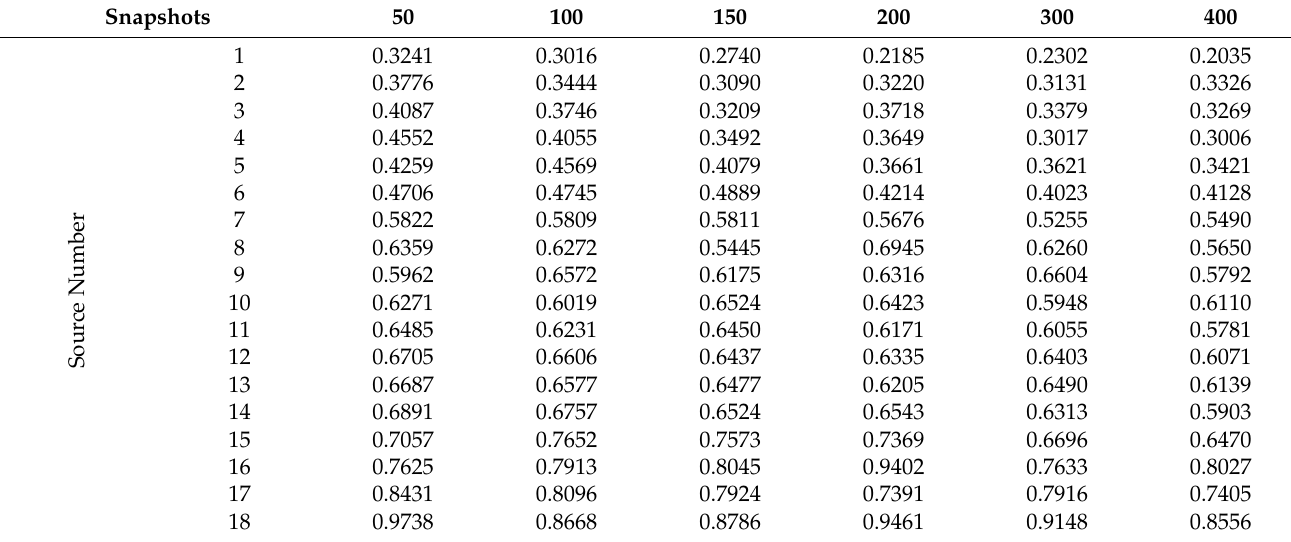
Table 8. RMSE of DOA estimation for ULA at different